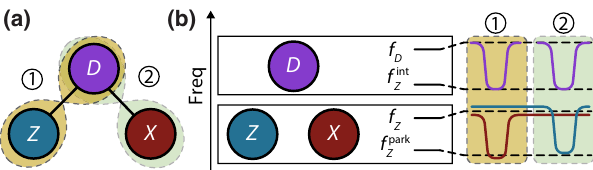
FIG. 14. Two-qubit gates in a multiqubit device . (a) A high frequency qubit, D , is coupled to two low-frequency qubits, Z and X . A CZ operation is to be implemented first between D and Z (step 1), followed by D and X (step 2). (b) To perform a CZ gate between D and Z , D detunes from f D to the interaction frequency f int while X must be moved to a parking frequency f park an unwanted interaction. Similarly, in step 2, a CZ gate between D and X is performed with Z detuned from its original frequency over the